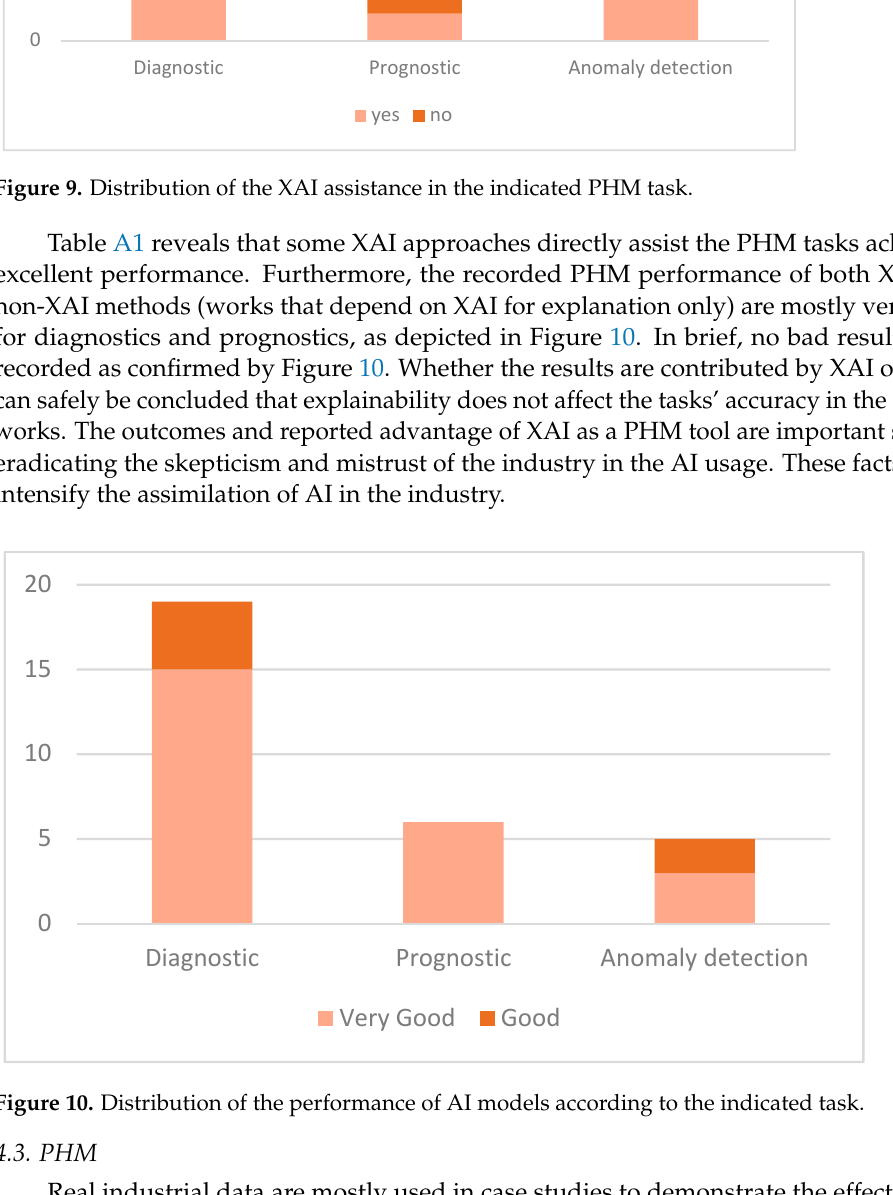
( d ) Figure 11. ( a ) Distribution of the type of case study in the selected articles; ( b ) distribution of human involvement (yes/no) in the selected articles; ( c ) distribution of explanation metric inclusion (yes/no)